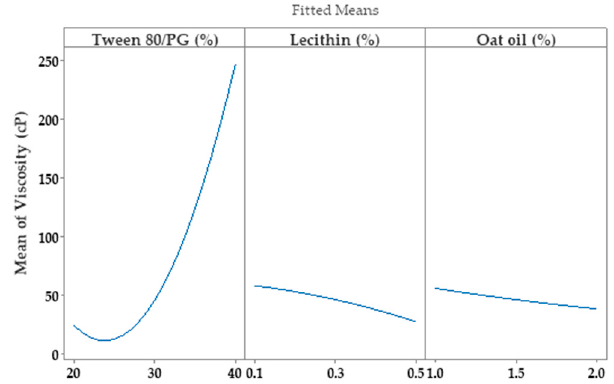
Figure 14. Main effects plot for viscosity response (Y 1 ), considering individual effect of each indepen- dent variable.